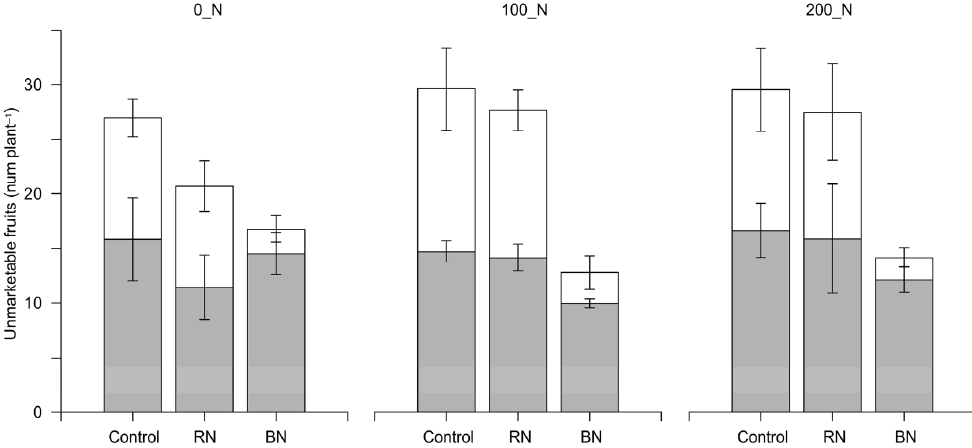
Figure 1. Number of unmarketable fruits (num plant − 1 ), as recorded in pepper plants subjected to different N fertilization rates (N_rates; 0_N: 0 kg N ha − 1 ; 100_N: 100 kg N ha − 1 ; 200_N: 200 kg N ha − 1 ) and shade levels (Sh; accomplished using: no cover, Control; red photoselective net, RN; black photoselective net, BN) in 2017. White chart: sunscald fruits; gray chart: fruits characterized by other disorders. Data are means ± standard errors, over Exp_1 and Exp_2 ( n =